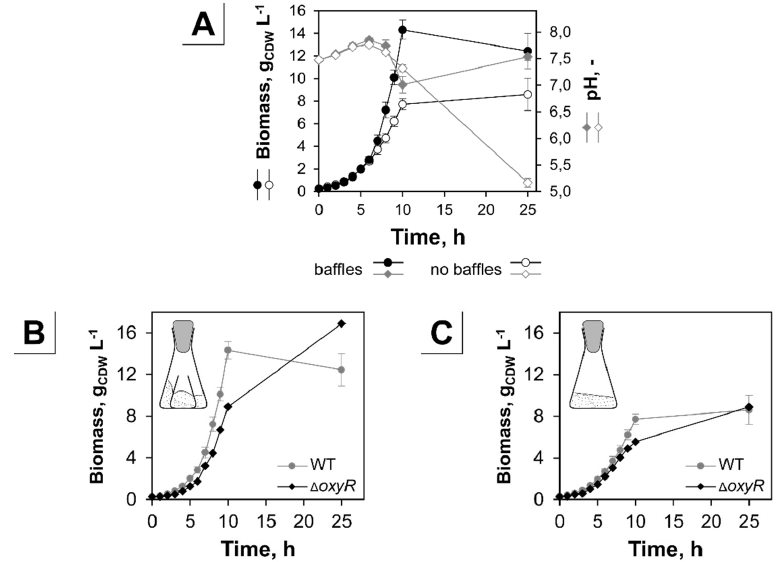
Figure A4. Cultivation of C. glutamicum WT and Δ oxyR under progressing oxygen limitation in shaking flasks with baffles or without baffles in CGXII + 40 g glucose L − 1 as sole carbon source. ( A ) WT cultivation in baffled (filled symbols) and unbaffled (open symbols) shaking flasks. ( B , C ) Cultivation of C. glutamicum Δ oxyR in shaking flasks with baffles ( B ) and without baffles ( C ). In both graphs the WT cultivation is shown in grey (circles). Error bars show SD of four independent cultivations of the C. glutamicum WT strain. For C. glutamicum Δ oxyR (black, diamonds) the average of two comparable independent cultivations is depicted. Table A1. Bacterial Strains, plasmids, and oligonucleotides.